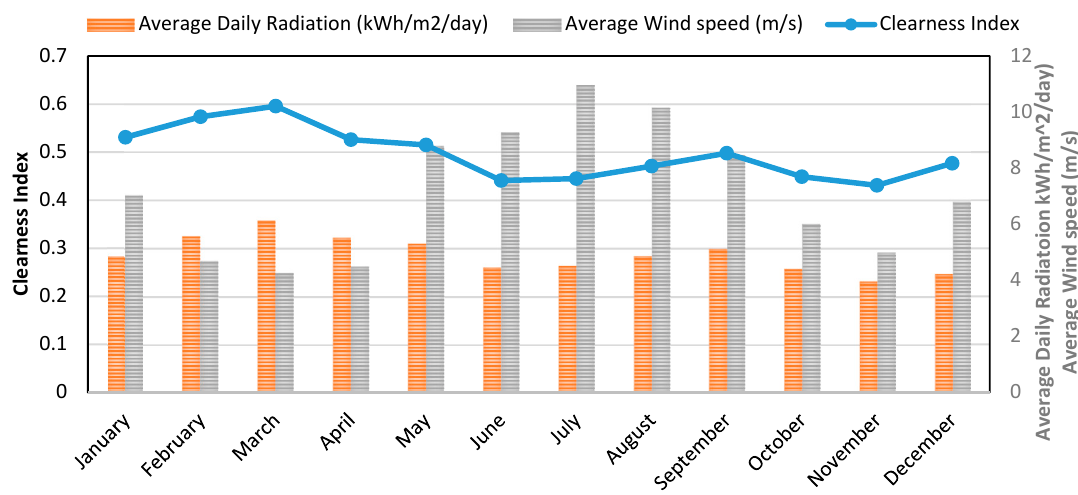
Figure 4. Solar and wind energy availability at Aralvaimozhi, India.